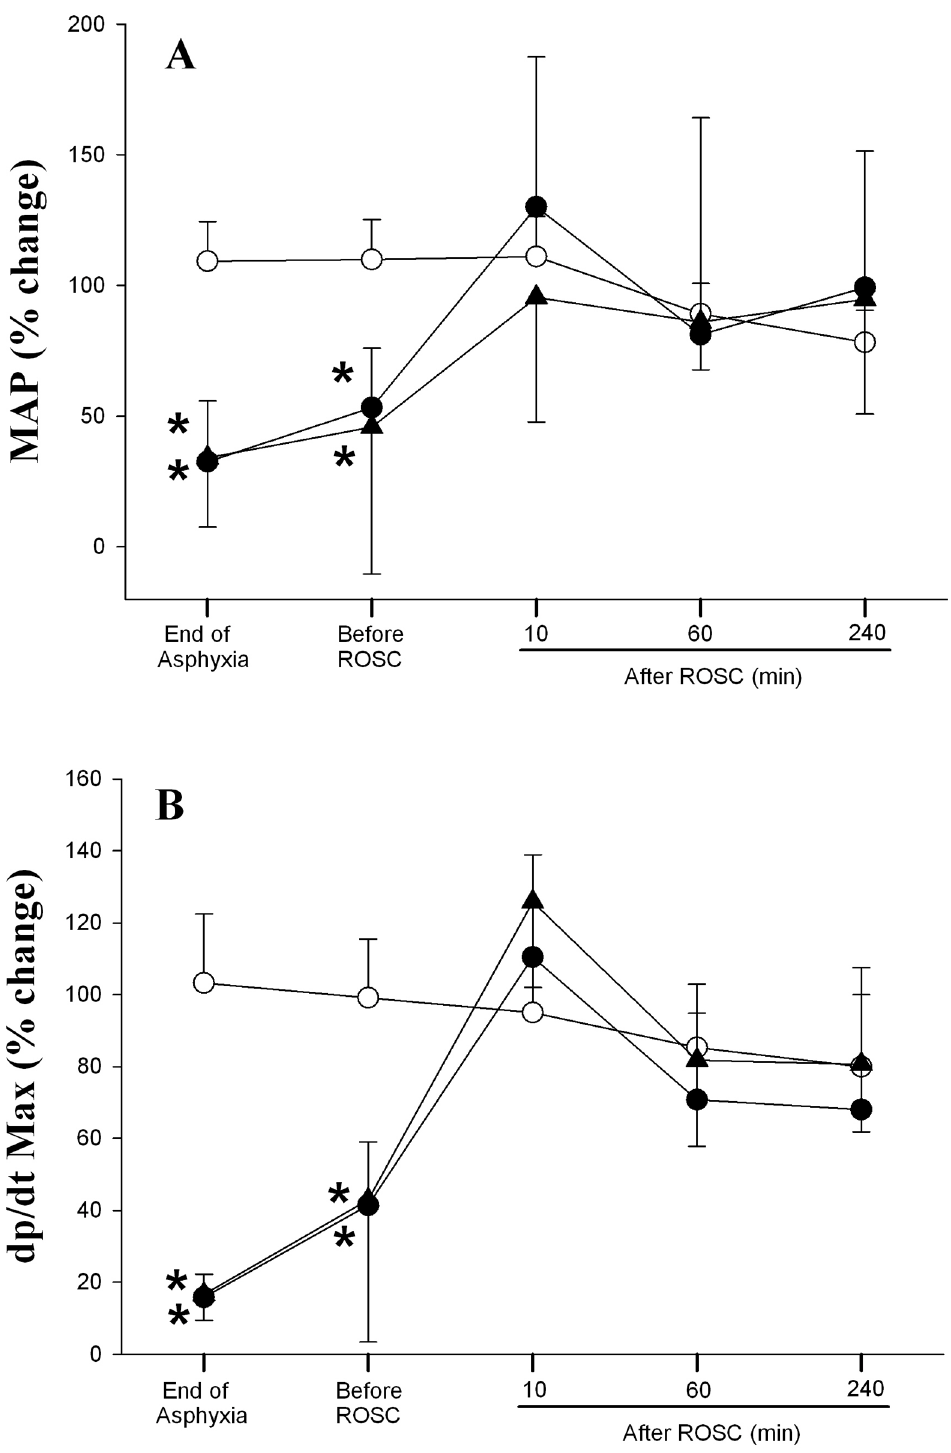
Fig 3. Percent changes from normoxic baseline in (A) mean arterial pressure (MAP), and (B) dp/dt max in sham ( ◯ ), SI+CC 90 ( ● ), and SI+CC 120 ( ▲ ) groups during and after resuscitation. Each point represents mean ± SD. * Significantly different from sham-operated group, p < 0.05 (Tukey).